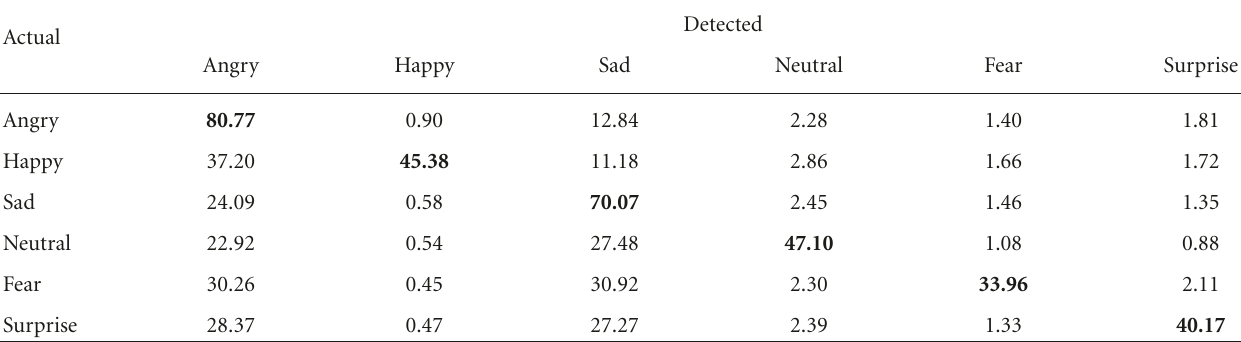
Table 7: Six emotions recognition rate (%) balanced speaker and text independent test-utterance based: 100 utterances per emotion, random sequence of speakers, SNR = 30 dB.